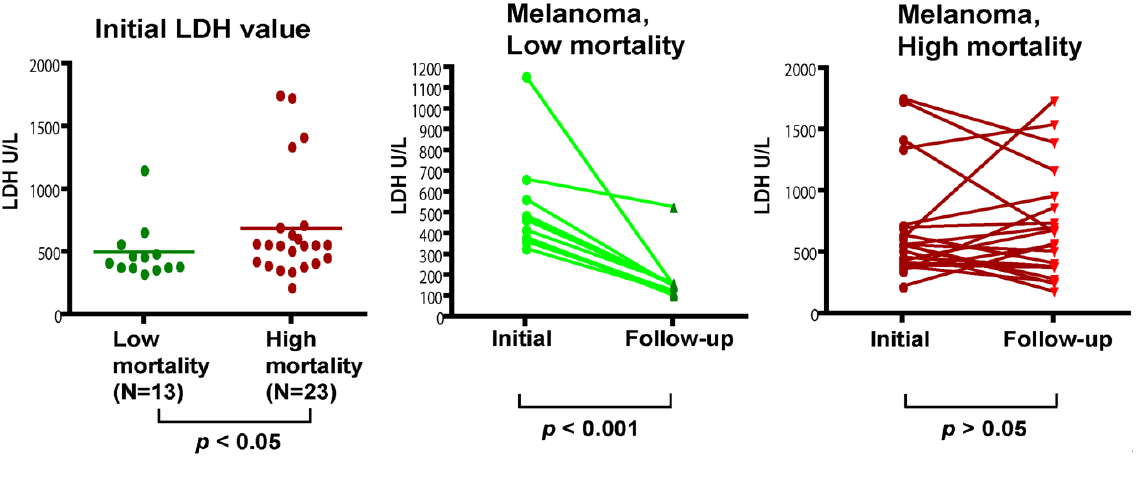
Figure 4. LDH as a prognosis marker for melanoma. Records of LDH levels of patients at the time of serum sample donation as well as 18-months later (or the last available LDH record if the patient died before 18-months follow-up) were examined. Patients in the High mortality group had significantly higher levels of LDH than those in the Low mortality group. The Low mortality group also showed significant reductions in LDH levels in the follow-up (paired t test, p < 0.001), while the High mortality group experienced no detectable changes in the LDH